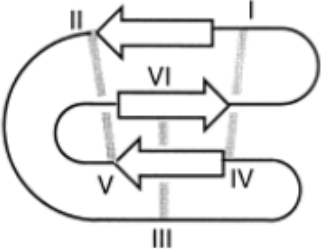
Figure 6. Schematic diagram of the cyclic cysteine knot with the cysteine residues labeled from I-VI and the resulting disulfide bonds shown as grey lines. Within the amide-cyclized backbone the disulfide bonds between the cysteines I and IV as well as II and V form the embedded ring being penetrated by the third disulfide bond between the cysteines III and VI. The β -sheets are represented by white arrows, forming the typical secondary structure element of cyclotides, a β -hairpin with a distorted third β -strand. Reproduced with permission from